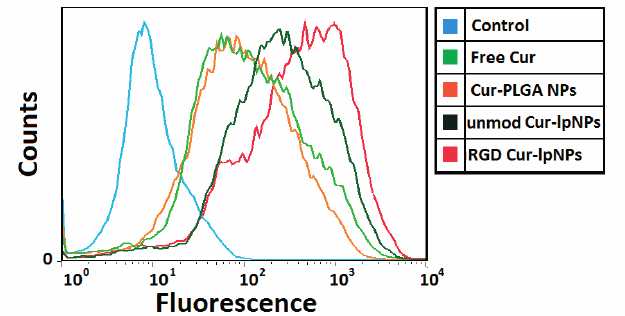
Figure 5. Flow cytometry profiles showed different cellular uptake of blank control (blue), free Cur (green), Cur loaded PLGA NPs (orange), Cur loaded lpNPs with Chol–PEG–RGD (red) and Cur loaded lpNPs without Chol–PEG–RGD (jasper) by human umbilical vein endothelial cells (HUVEC) (containing 40 ng/mL coumarin at 37 °C for 1 h).